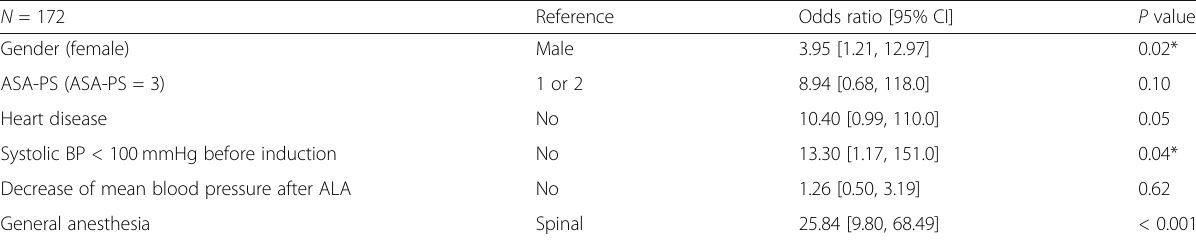
Table 3 Multivariate analysis in normal and hypotension groups N =